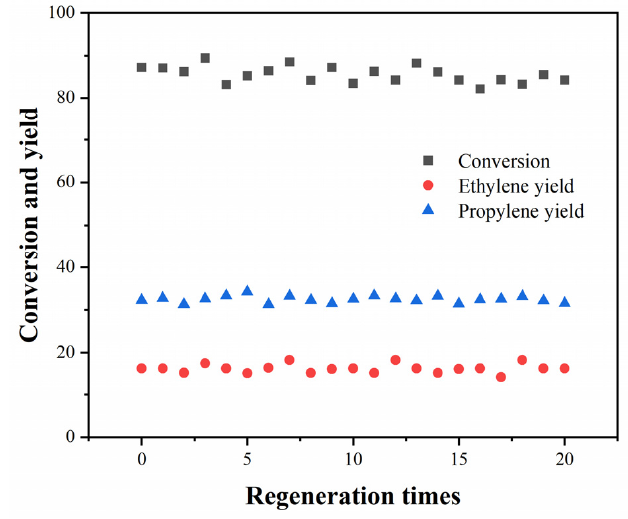
Figure 12. Regeneration performance evaluation of H-ZSM-5 zeolite. Reaction conditions: total pressure, 130 kPa; partial pressure, 60 kPa; 650 ◦ C; WHSV, 83 h − 1 . Regeneration conditions: 670 ◦ C; Compressed air (120 mL · min − 1 ) sweeps for 10 min.